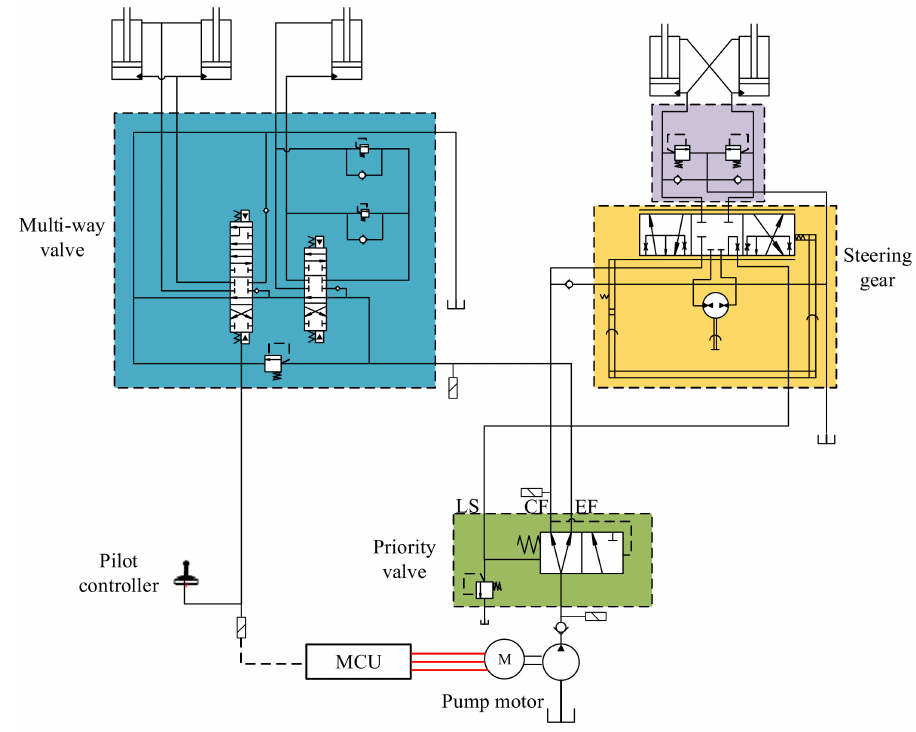
Figure 3. Schematic diagram of the positive flow system based on the variable speed and quantitative pump.